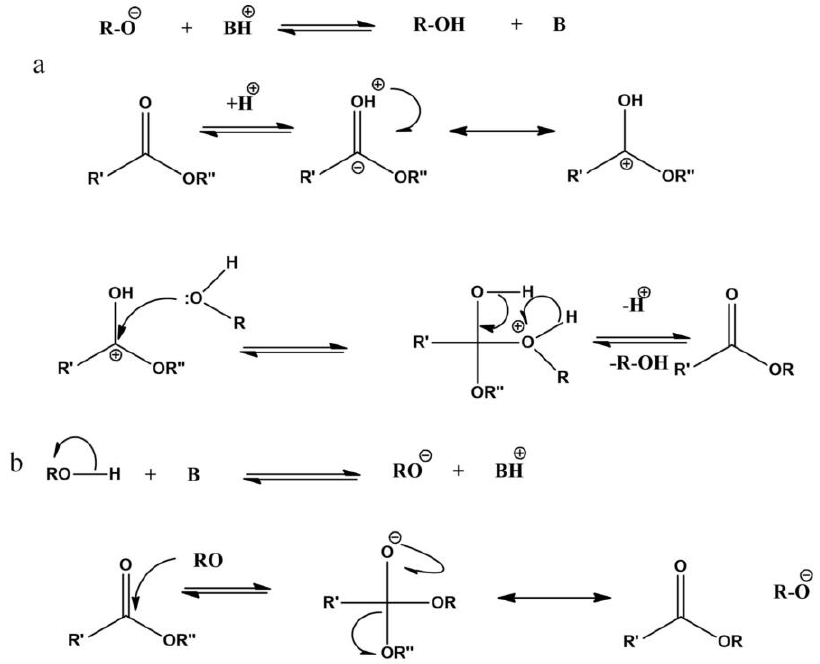
Catalysts 2023 , 13 , x FOR PEER REVIEW 8 of 25 Figure 3. Chemical reactions of ( a ) acid-catalyzed transesterification reaction pathways and ( b ) base- catalyzed transesterification. Data adapted from [73], open access journal of catalysts, 2021.